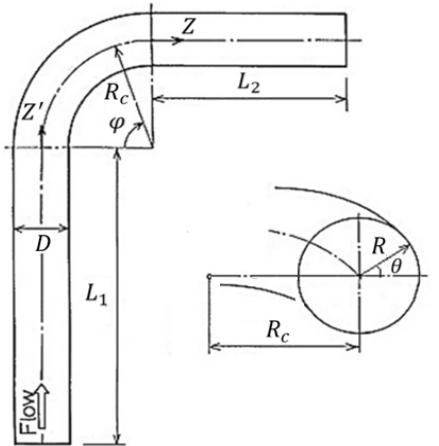
Figure 1. Definition of the geometric parameters in the models. Table 1. Dimensions pipeline validation cases.